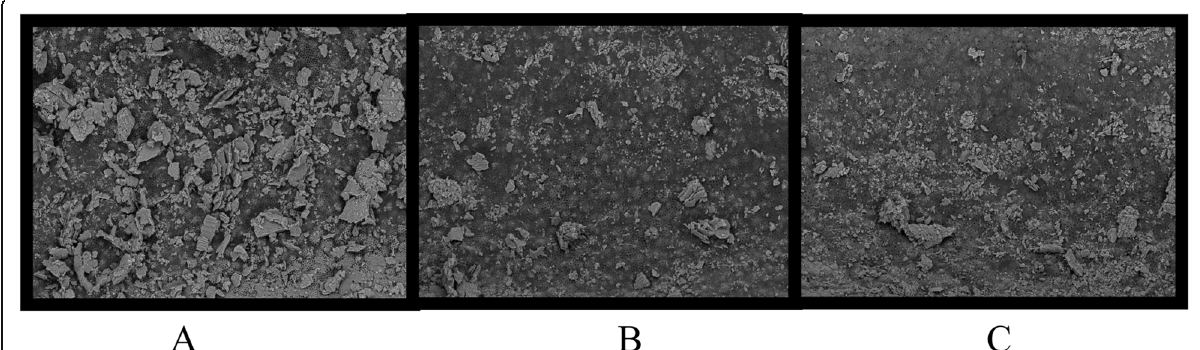
Fig. 6 SEM images of group 1. a Coronal. b Middle. c Apical